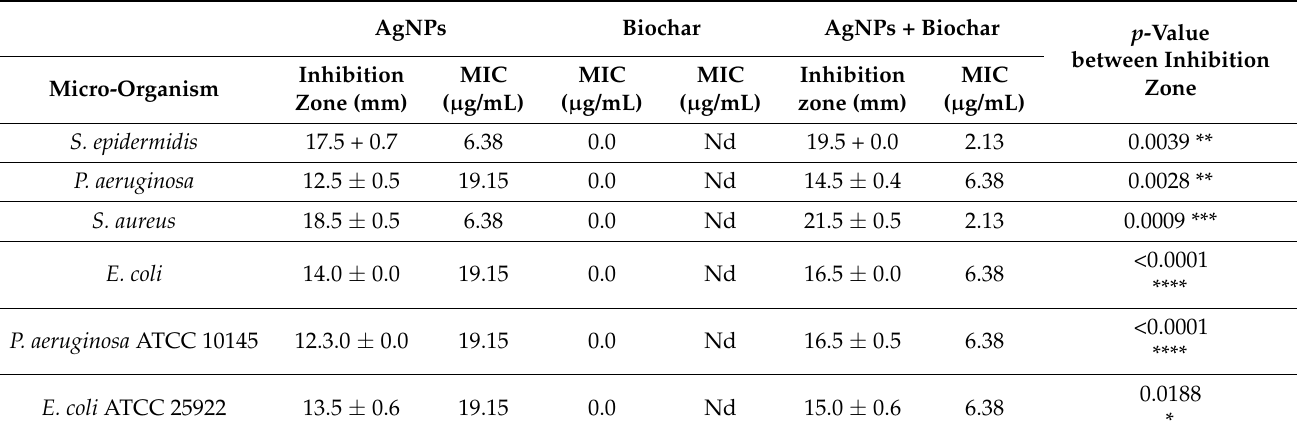
Table 1. Inhibition zones and MIC values of AgNPs, biochar and AgNPs +